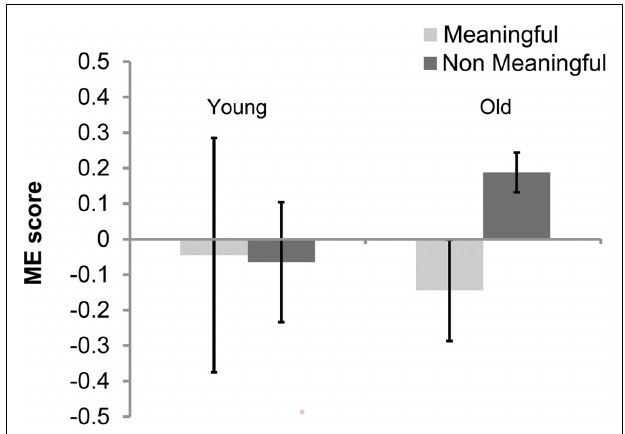
FIGURE 4 | Multisensory enhancement scores for younger and older adults for recall of meaningful and non-meaningful sentences.